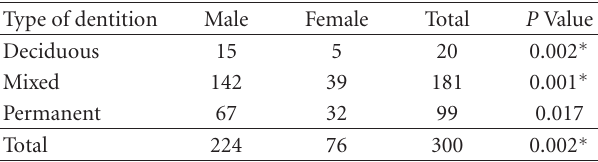
Table 1: Distribution of supernumerary teeth by dentition and sex. ∗ Denotes statistically significant values ( P < 0 . 01).